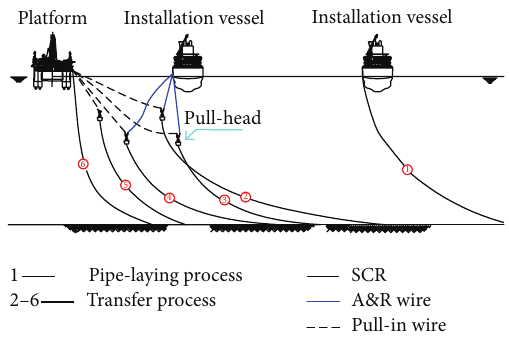
Figure 3: Catenary axis and